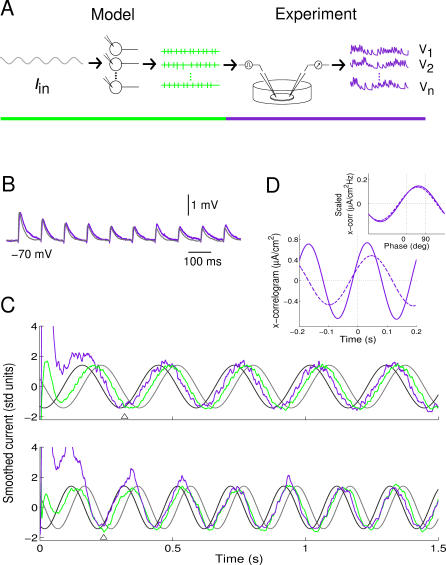
Experimentally, Real Cortical Synapses Produced Constant Phase Advance and Modulation Gain Proportional to Frequency(A) Experiment scheme. Electric shocks were triggered by the sequentially chained spike trains of ∼400 presynaptic model cells. Postsynaptic responses in an intracellularly recorded neuron were analysed off-line, translated in synaptic conductances, and added together to simulate the putative total synaptic conductance evoked by the simultaneous activation of ∼400 presynaptic neurons. The voltage-clamped postsynaptic current I
post is represented.(B) Control recording for periodic stimulation at 10 Hz (purple) and model trace given by Γ = 0.65 (gray) (Γ is the ratio of peaks of contiguous postsynaptic currents at very high stimulation rates).(C) Smoothed postsynaptic current phase advance in the model with SFA only (green) was enhanced when replacing nondepressing model synapses by real cortical synapses (purple). Results for two different I
in frequencies are shown (top: 3.5 Hz, bottom: 5 Hz). Signals are plotted normalized to s.d. (computed from triangles onward to avoid transients).(D) Cross-correlation functions between I
in and non-s.d.–normalized experimental I
post for the two frequencies (dashed: 3.5 Hz, solid: 5 Hz) overlapped when plotted versus phase and when normalized by stimulation frequency (inset). All data shown here come from the same neuron.